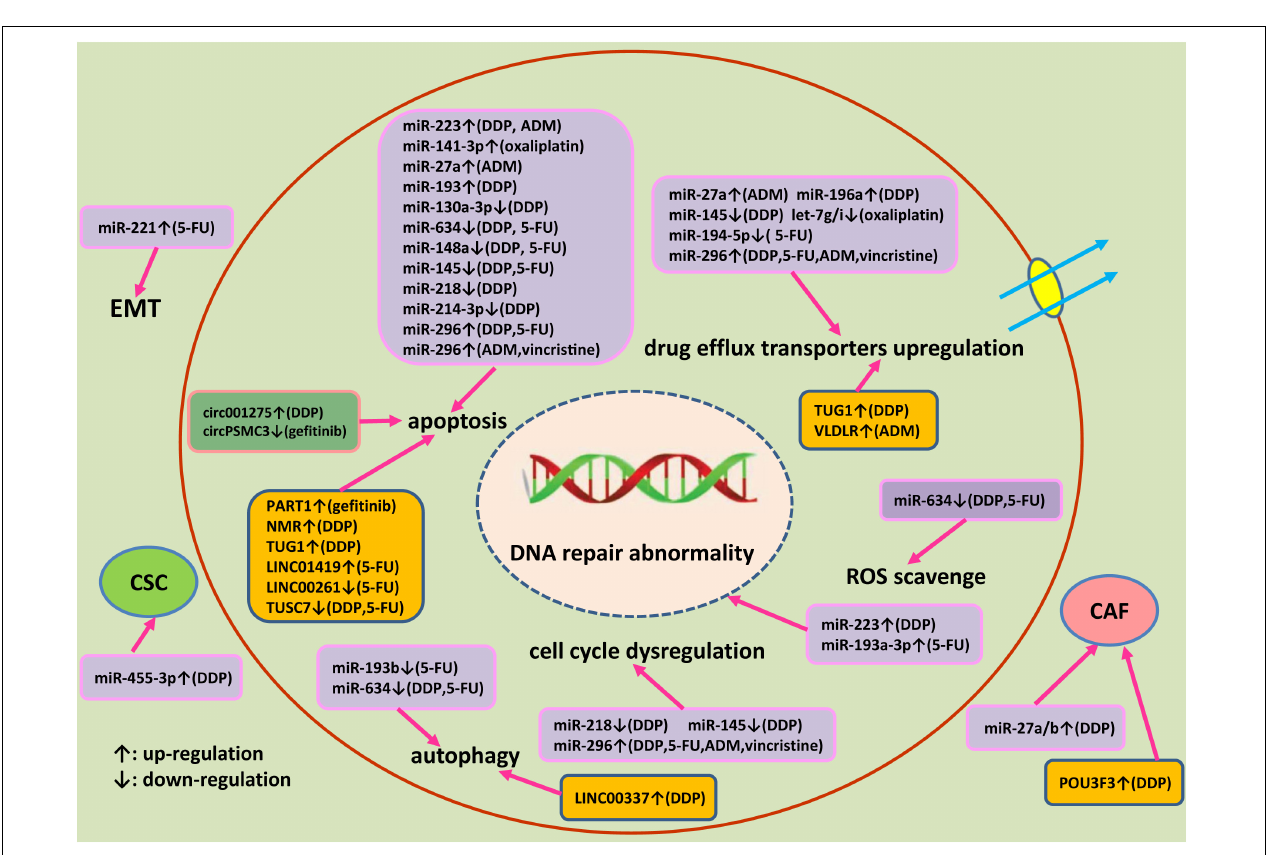
FIGURE 2 | An outlined diagram of miRNAs, lncRNAs, and circRNA involved in the drug resistance of esophageal cancer. Multiple miRNAs, lncRNAs, and circRNA have been found to be linked to the drug resistance of esophageal cancer through altering cell proliferation, apoptosis, DNA damage repair, cell cycle progression, autophagy, cancer stem cell, and epithelial-mesenchymal transition via modulating corresponding target genes and signaling pathway.